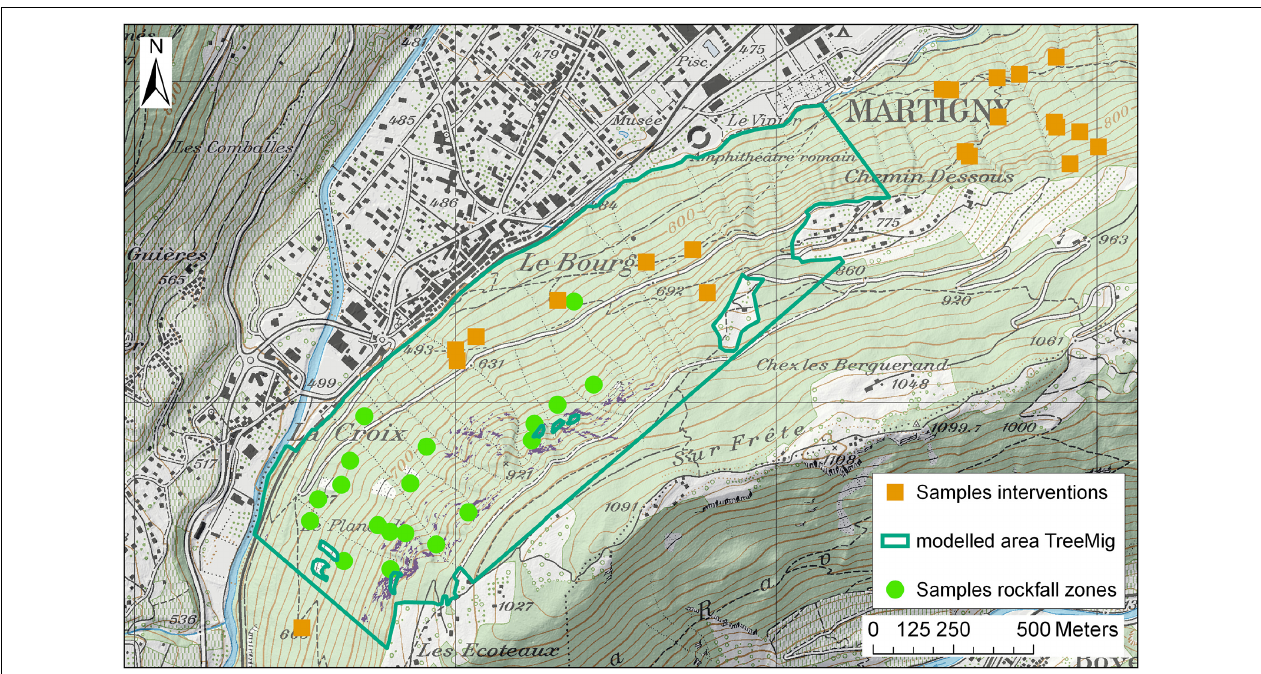
FIGURE 1 | Study area with sample plots in the intervention areas (orange squares), sample plots in the rockfall zone (green dots), and the forest area modelled in TreeMig (dark